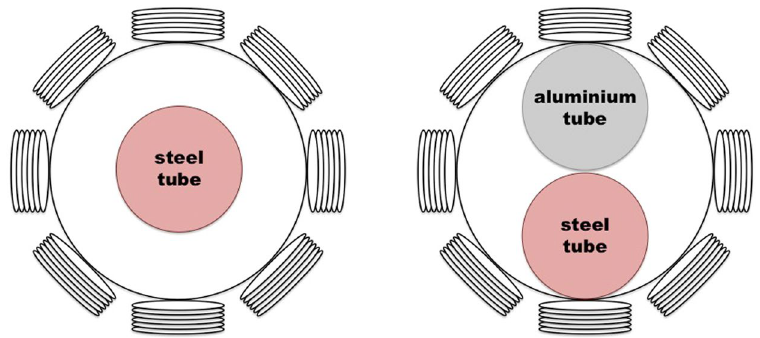
Figure 5. Experimental setup of a steel tube (OD50.76 mm) positioned in the centre of the imaging region ( A ), and an aluminium tube (OD50.76 mm) and a steel tube (D50.76 mm) positioned side by side in the imaging region ( B ).